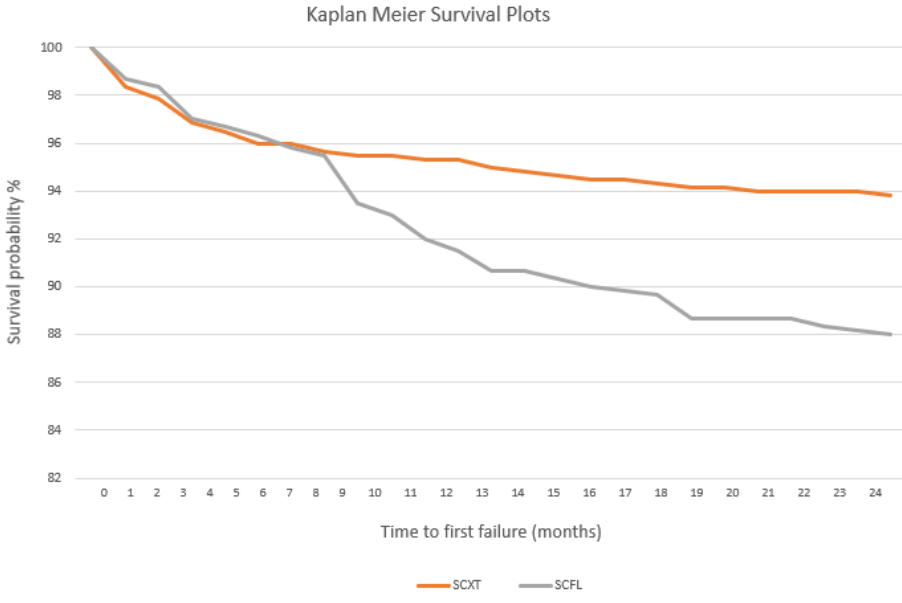
Figure 5. Kaplan-Meier survival curves of retainers bonded with the two different resins.